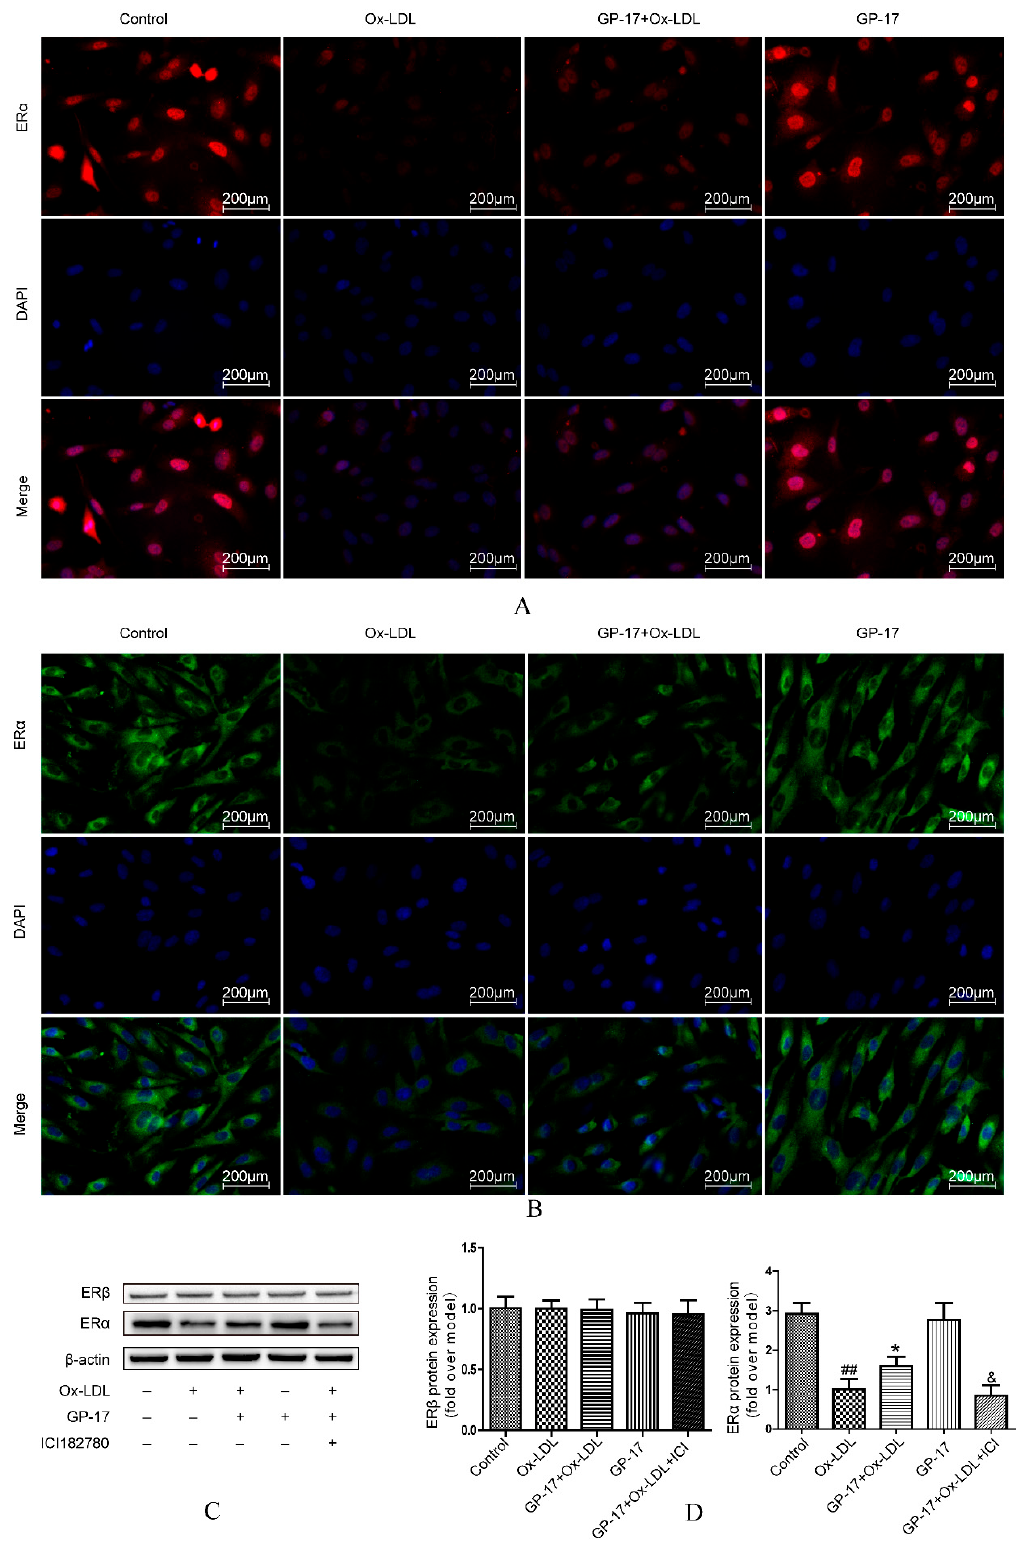
Figure 8. Effect of GP-17 on ER α in Ox-LDL-treated HUVECs. ( A ) Localization of ER α immunoreactivity was identified in the cytoplasm by immunofluorescence assays; ( B ) Localization of ER α immunoreactivity was identified in the plasma membrane by immunofluorescence assay; ( C , D ) The expressions of both ER α and ER β were analyzed by western blots of Ox-LDL-induced HUVECs. The values are expressed as the mean ± S.E.M. from three independent experiments. ## p < 0.01 vs. Control; * p < 0.05 vs. Ox-LDL; & p < 0.05 vs. GP-17 + Ox-LD. DAPI, 4,6-diamidino-2-phenylindole.